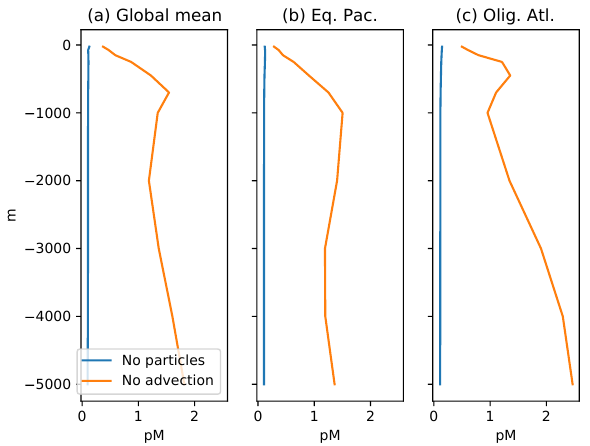
Figure 9. Time series of the ocean load of Hg (Mmol), in response to 250 years of enhanced Hg(II) deposition (1850–2100), followed by abrupt return to natural Hg deposition rates, or 1000-year wind- down in anthropogenic deposition due to recycling from the